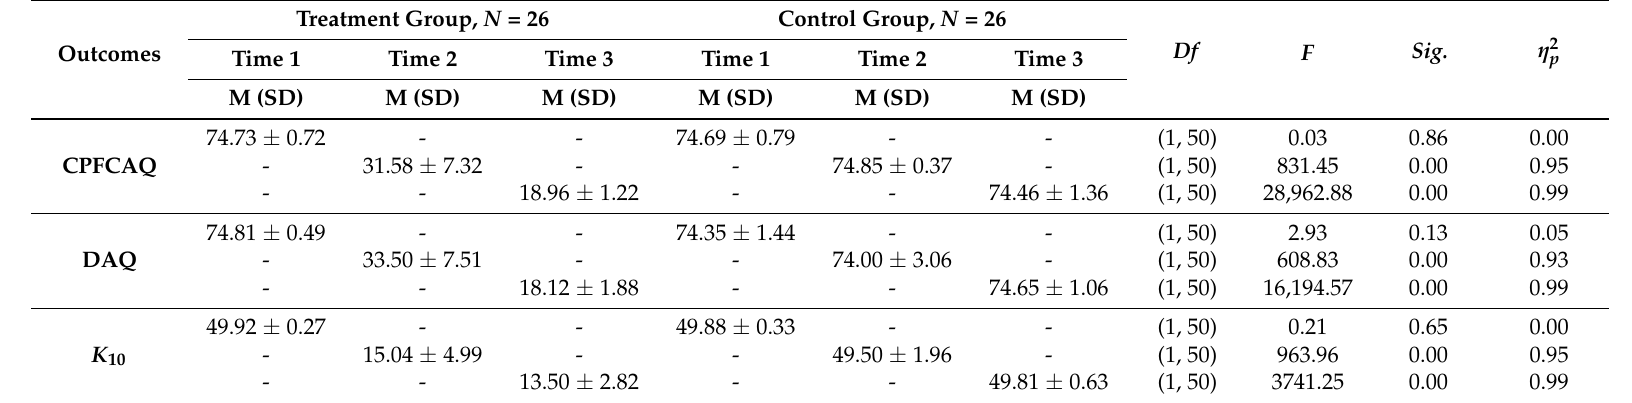
Table 3. Summary statistics from repeated measures ANOVA on effects of a rational emotive hospice care therapy (REHCT) intervention on family caregivers’ problematic assumptions, death anxiety, and psychological distress by treatment condition and